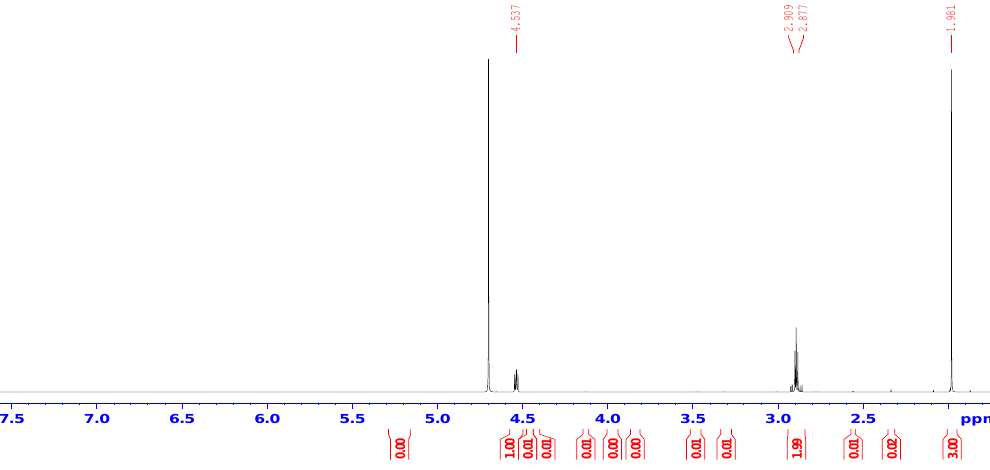
Figure 3. 1 H NMR spectrum of purified N -acetylcysteine molecule.